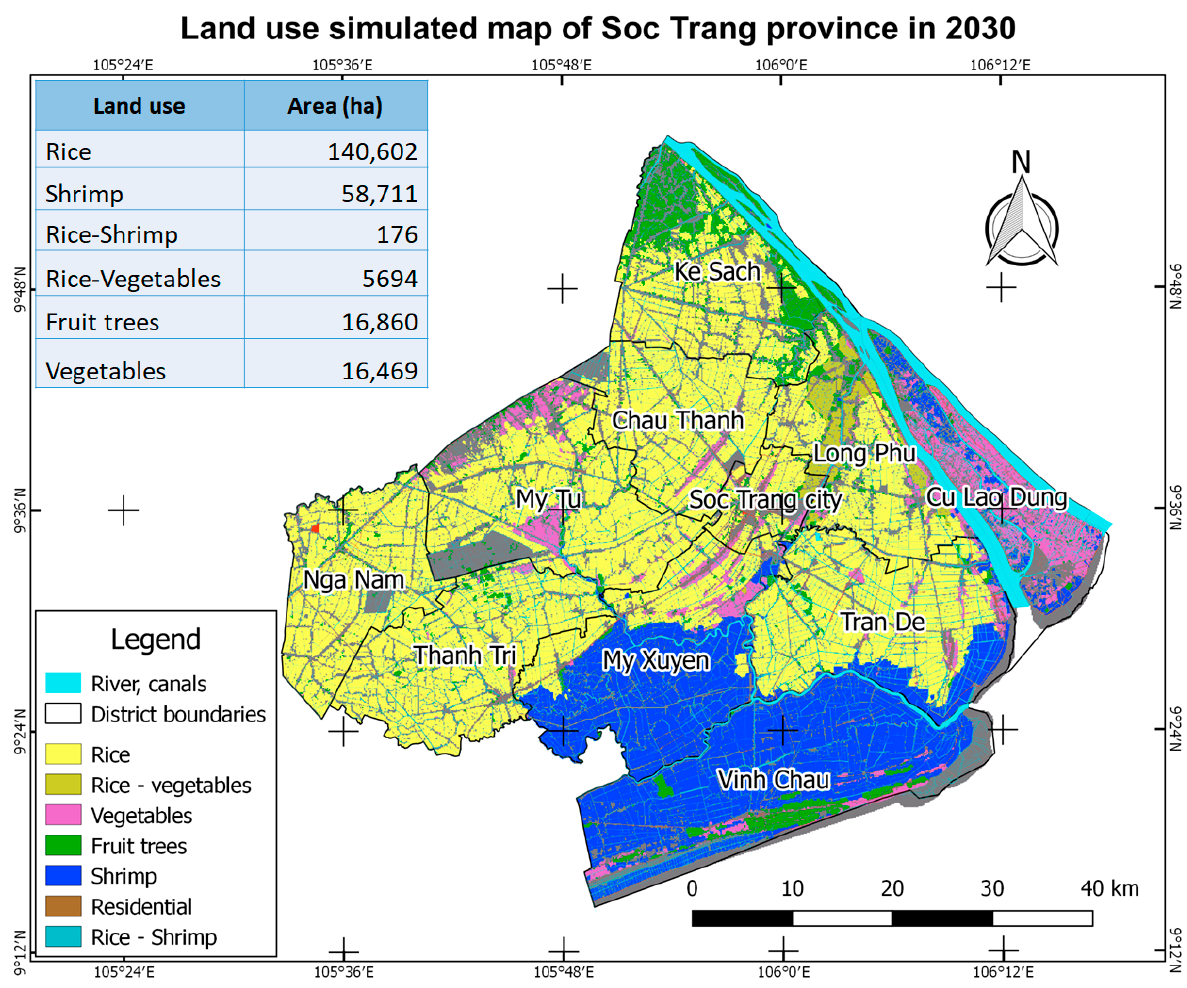
Figure 9. Simulated land-use map for 2030.